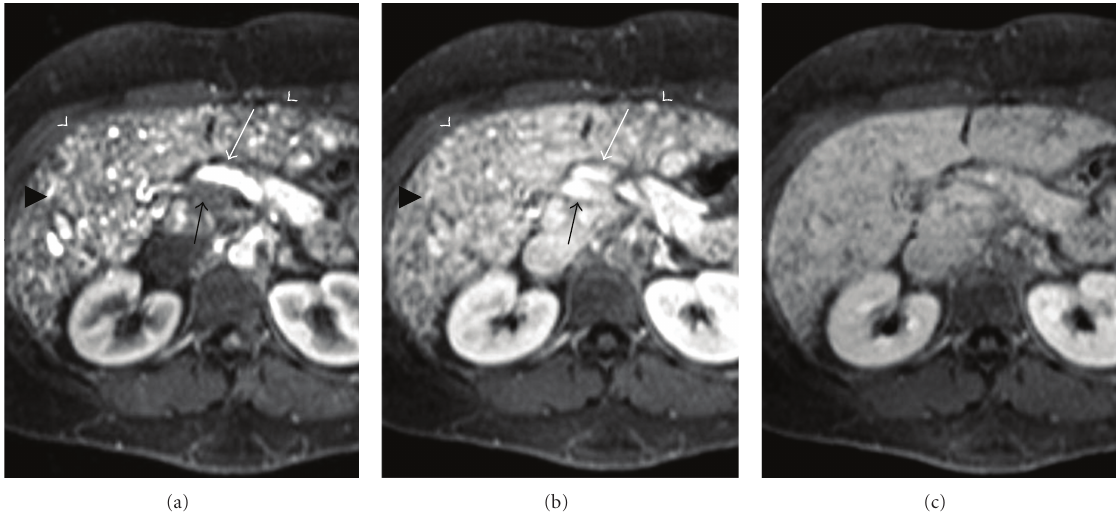
Figure 3: Axial dynamic MRI in the arterial phase (a), the portal venous (b), and the late venous phase (c). The early venous drainage with the simultaneous opacification of the right hepatic veins and the hepatic artery (black arrowheads) is evident during both arterial phases. The portal vein (arrow) is not opacified during arterial phase but it is opacified in portal phases. The hepatic parenchyma is inhomogeneous due to the presence of several millimetric hypervascular foci, consistent with telangiectasias (arrowheads). These inhomogeneities are no longer seen during the late venous phase.